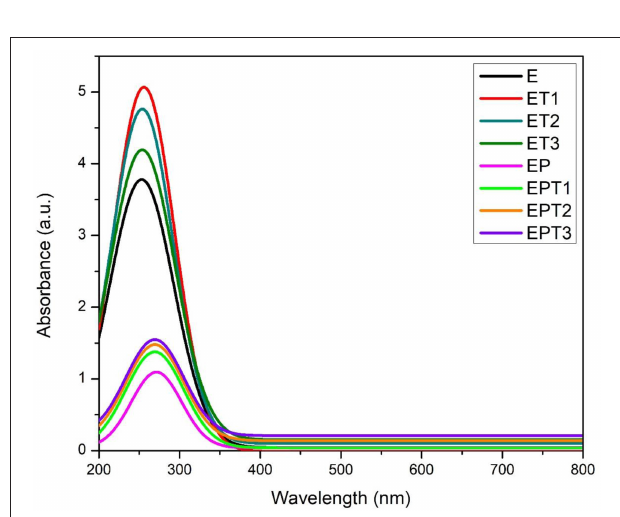
FIGURE 6 | UV-Vis absorbance spectrum of all developed coating